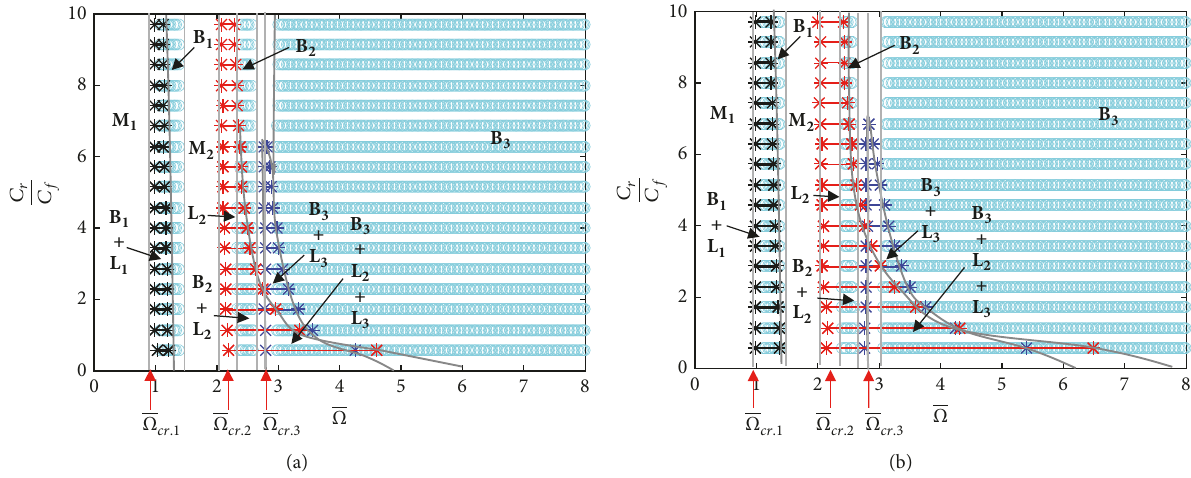
Figure 10: Effect of damping ratio 𝐶 𝑟 /𝐶 𝑓 and rotor speed ratio Ω on stable balanced, merged, and limit cycle regions for (a) 𝑚 𝑏 = 0.002 kg and (b) 𝑚 𝑏 = 0.003